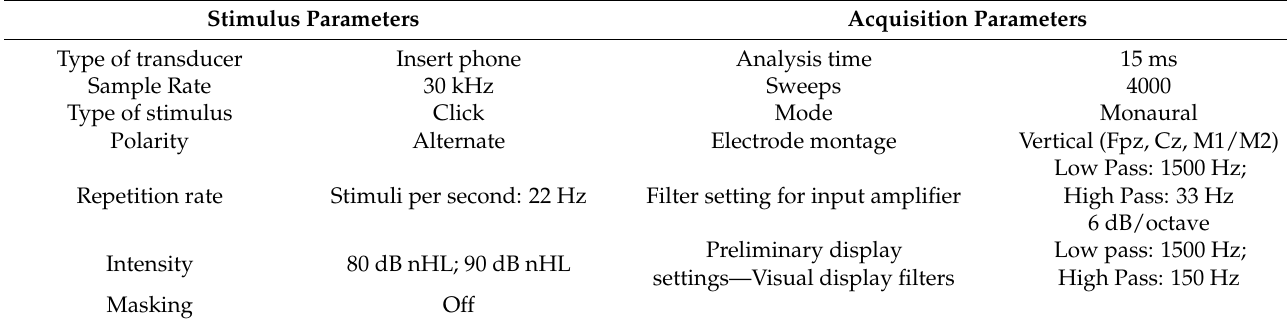
Table 1. Stimulus and acquisition parameters for ABR recordings.